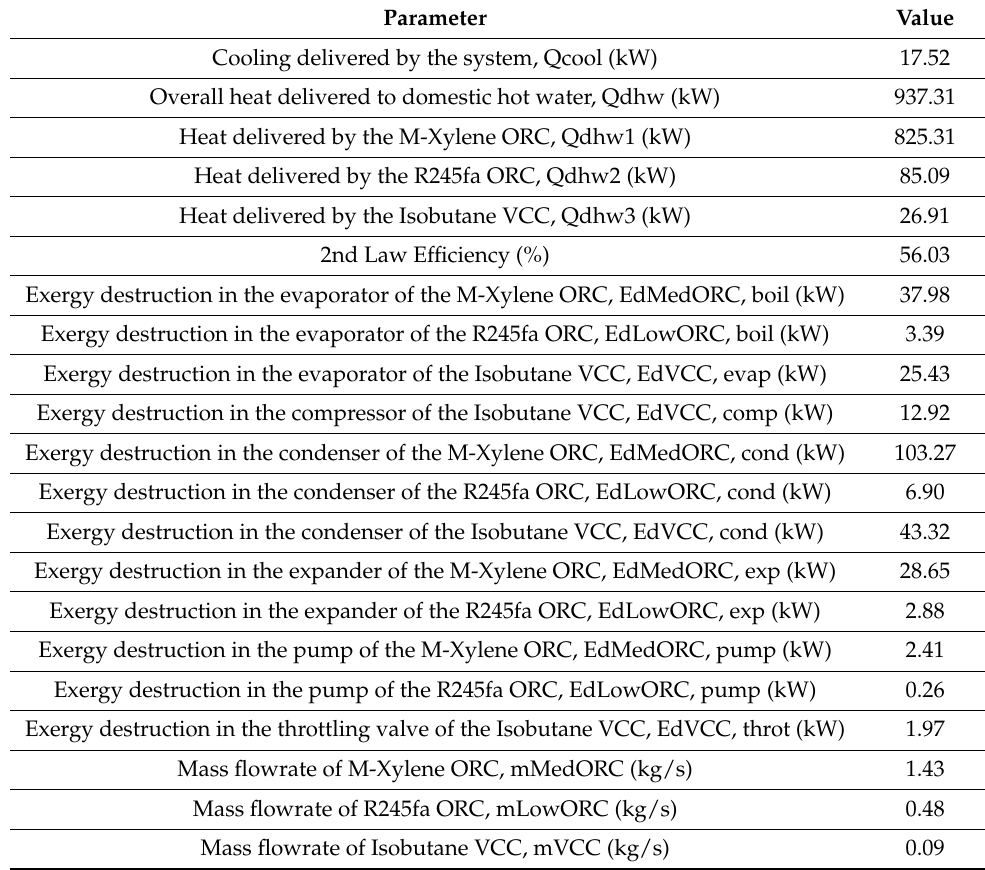
Table 5. Results at the baseline